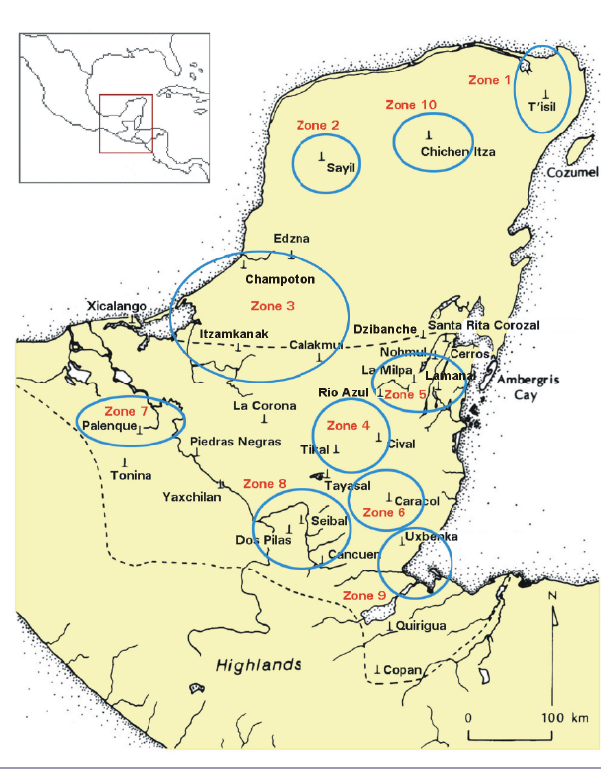
Fig. 1 . Map of the Yucatan Peninsula showing Integrated History and Future of People on Earth (IHOPE)–Maya zones of interest (adapted from Chase et al., 2014).